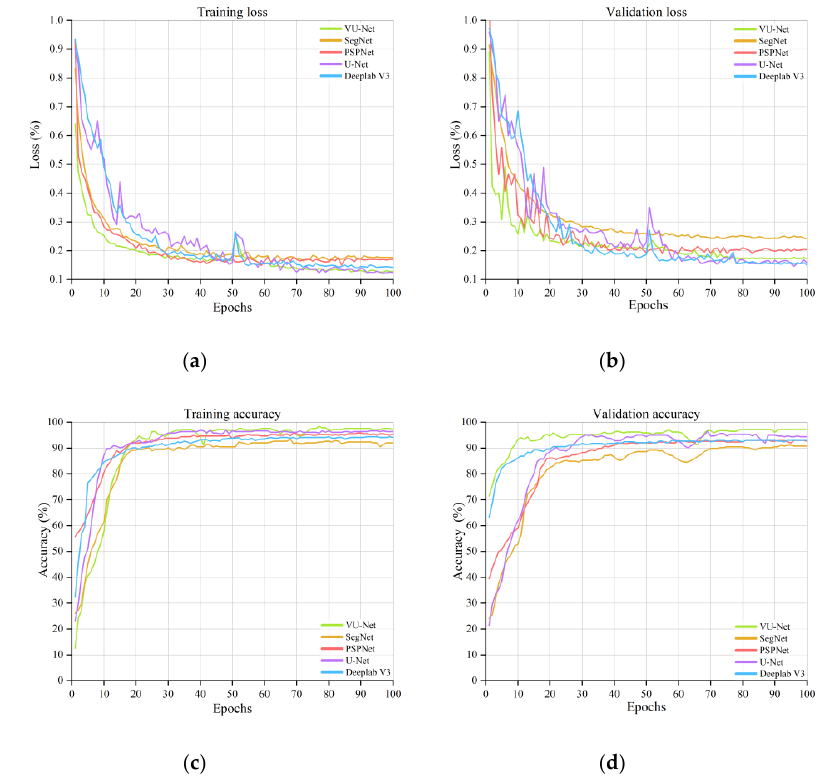
Figure 9. Loss function curve of each model: ( a ) training loss function curve; ( b ) validation loss function curve; ( c ) training accuracy; ( d ) validation accuracy. To test the effect of the training model on the segmentation of potato rows in different growth periods and light intensities, we conducted segmentation experiments under var- ious growth periods and in various light intensities. For each period of growth, the images were divided into three sets, with each set containing a total of 100 images, 50 of which were high-light intensity photos and 50 of which were weak light-intensity photos. Figure 10 shows the segmentation results for potatoes at various periods of growth and in differ- ent lighting conditions. The segmentation accuracy results are shown in Table 3 under various conditions. As shown in Table 3, the accuracy rate and MIOU value decreased by 1 – 2 percentage points under the same growth period conditions when the light intensity was increased. These results in Figure 10c,g show that, under strong light conditions, tree shadows near the road occluded the crop rows in the distance, resulting in incorrect